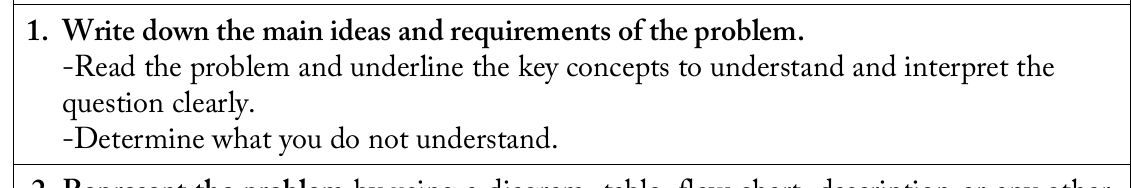
Table 1: The problem-solving activities framework (Adapted from Problem solving Activities: SANPAD Project, M. Havenga, 2011) Main problem-solving